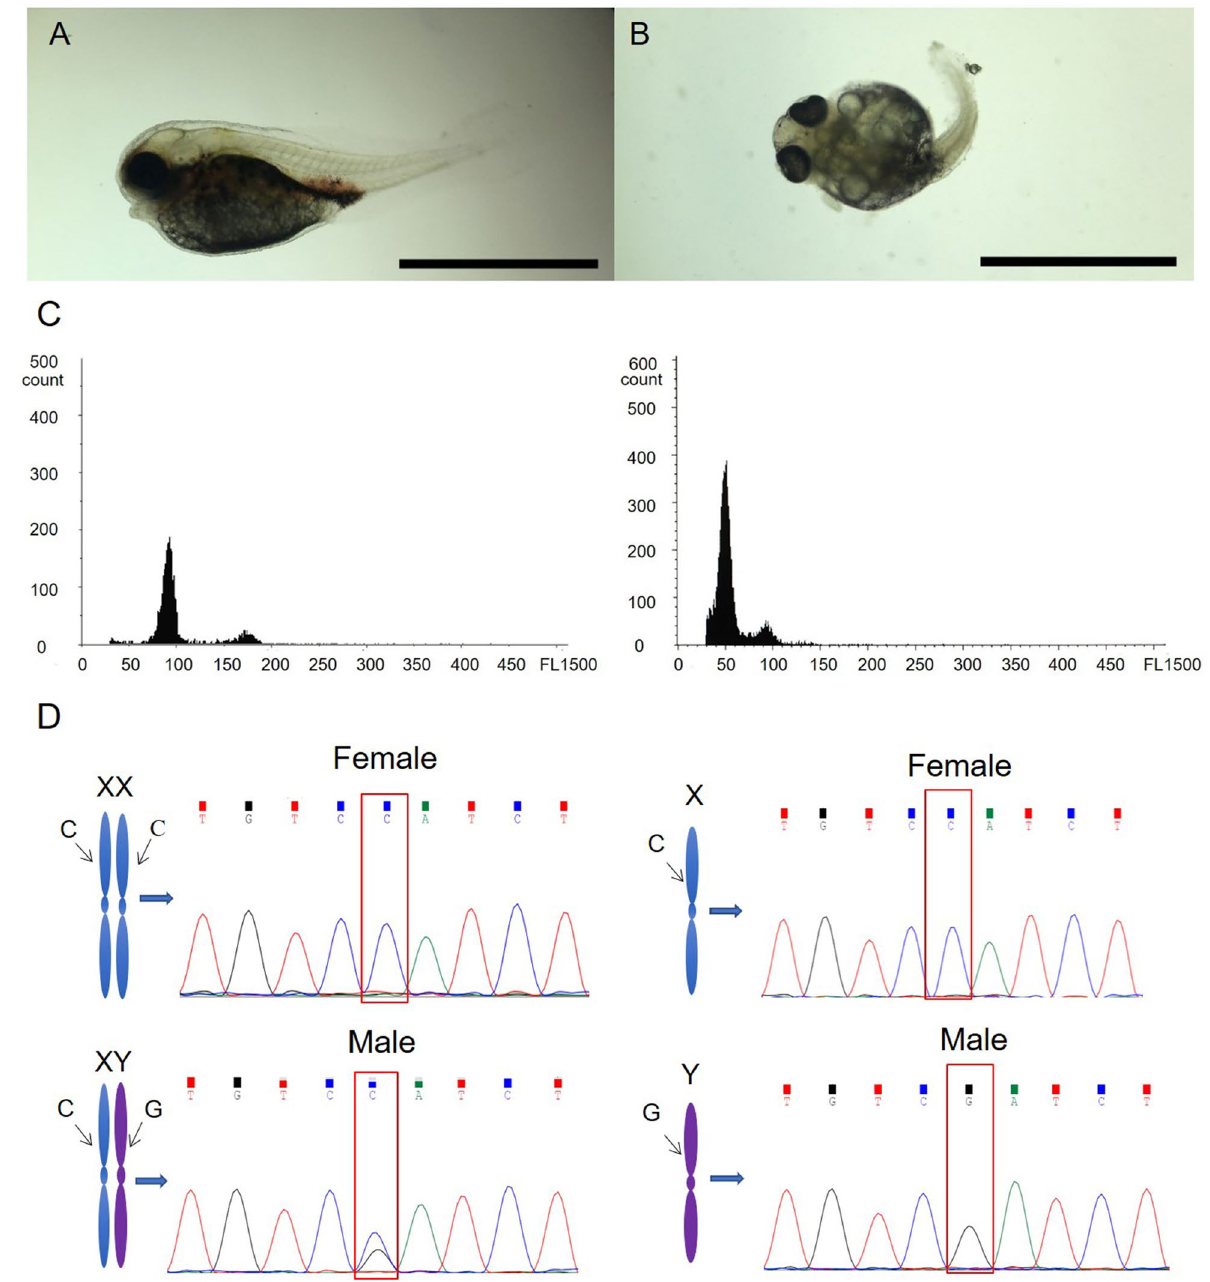
Figure 1. Sex identification of haploid and diploid tiger pufferfish ( T. rubripes ). Morphological observation of a representative fish from diploid group ( A ) and haploid group produced by cold-shock ( B ). Bar = 0.5 mm. ( C ) Flow cytometry results of diploid (left panel) and cold-treated haploid (right panel) tiger pufferfish. ( D ) Genetic sex identification of tiger pufferfish. SNP genotypes of the amhr2 gene in female and male diploids (left panel) were CC and CG, respectively. SNP genotypes in female and male haploids (right panel) were C and G, (Fig. 1C). The specific SNP locus in the amhr2 gene was sequenced. The genotypes of female and male diploid tiger pufferfish were CC and CG, respectively. In haploid tiger pufferfish, the genotypes of genetic female and male haploid were C and G, respectively (Fig. 1D). WGBS data. To evaluate the DNA methylation patterns across different chromosome ploidy and sex of tiger pufferfish, we performed WGBS on genomic DNA extracted from haploid females (1n-X) and males (1n-Y), and diploid females (2n-XX) and males (2n-XY). A total of 96.32 Gb clean data were produced from the eight